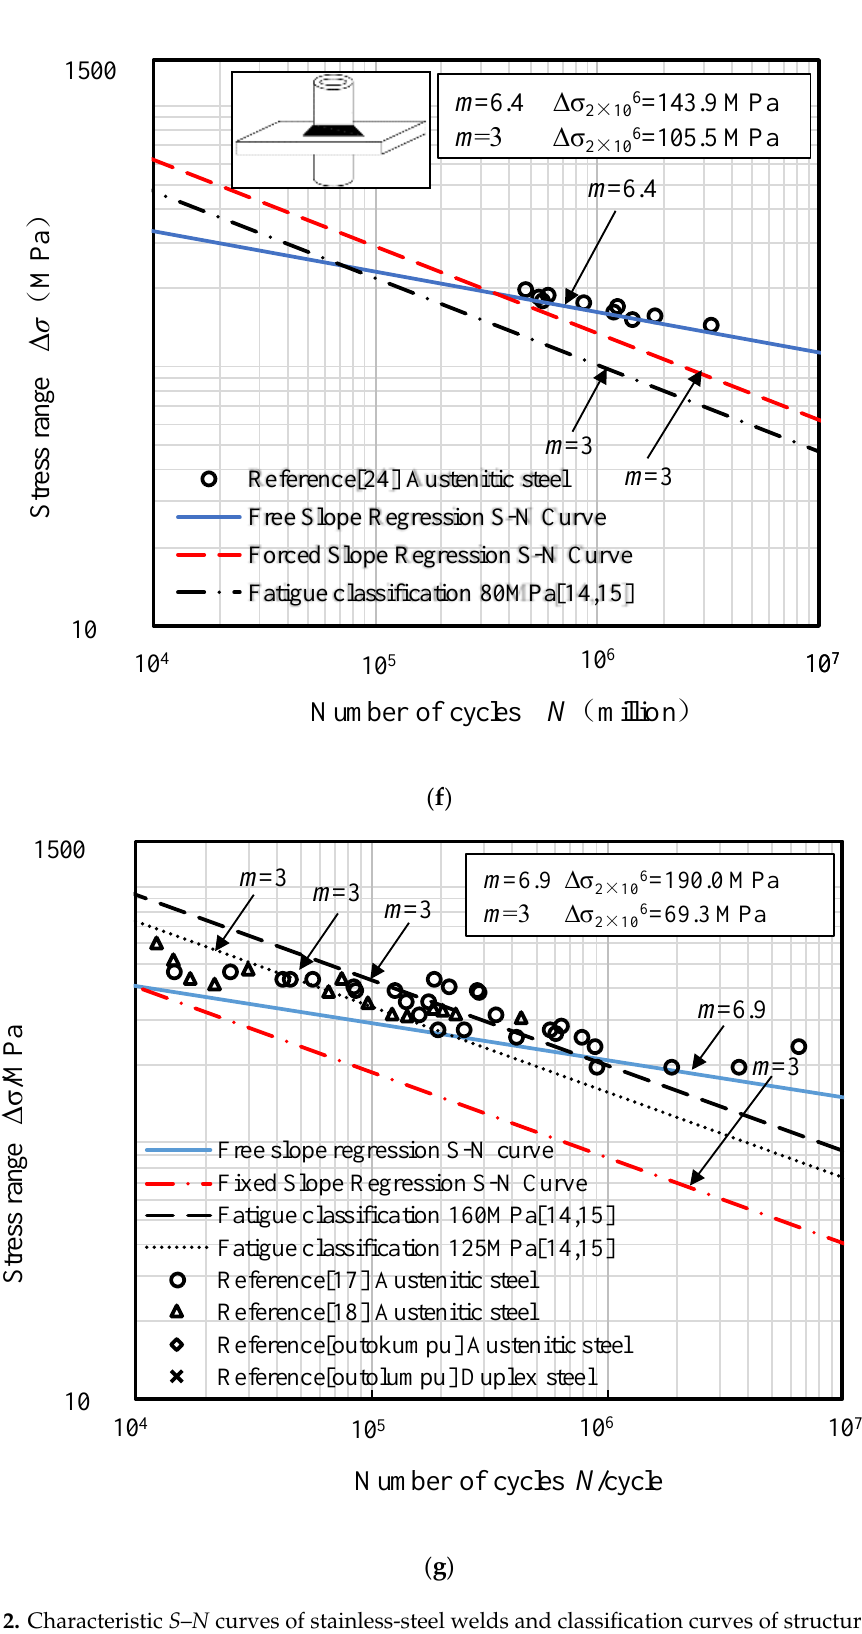
Figure 2. Characteristic S – N curves of stainless-steel welds and classification curves of structural-steel welded joints: ( a ) butt weld; ( b ) cruciform joints failing in the weld throat; ( c ) plates with transverse fillet-welded attachments; ( d ) plates with longitudinal fillet-welded attachments; ( e ) plates with longitudinal edge gussets; ( f ) fillet-welded joints with longitudinal round pipes; ( g ) base metal.